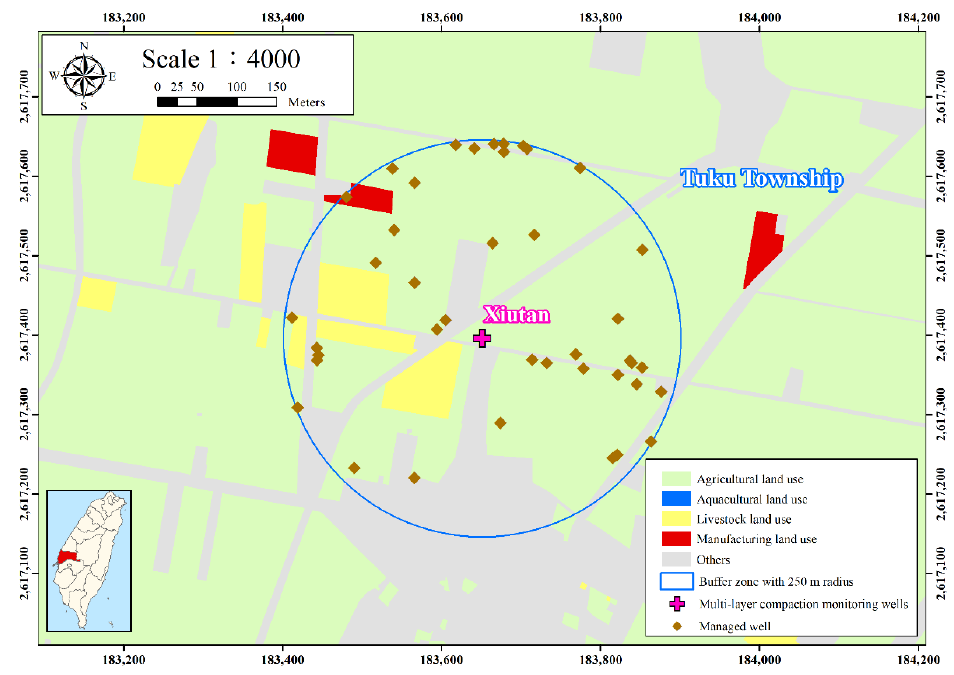
Figure 4. The buffer analysis tool in ArcGIS.